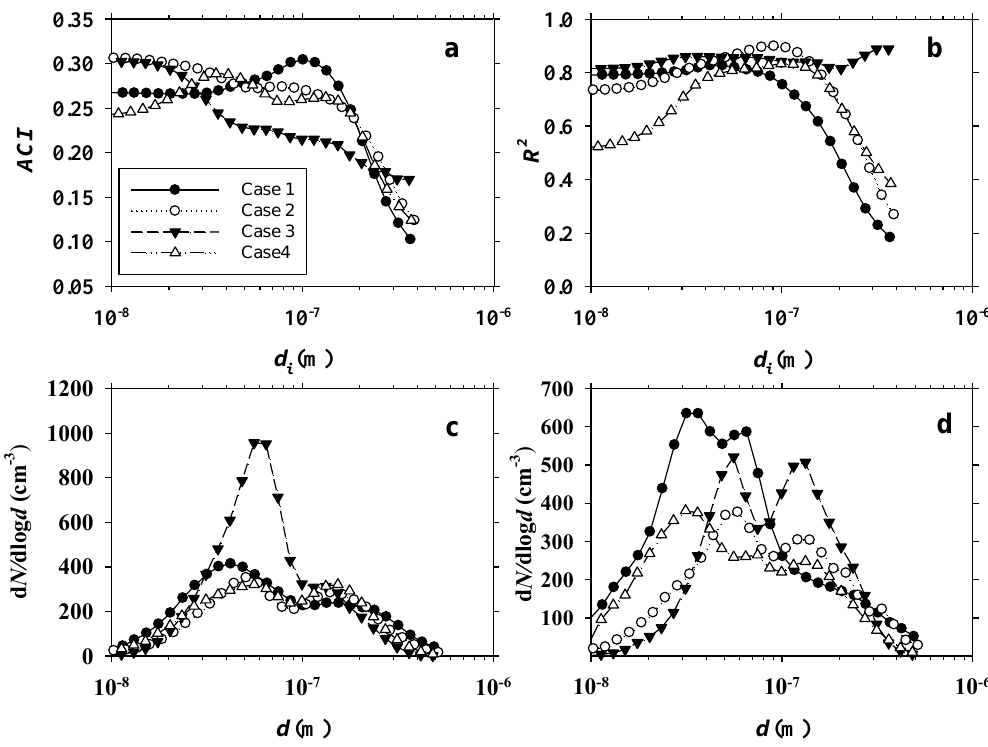
Fig. 1. (a) Aerosol-cloud interaction (ACI) from in situ data in different cases as a function of particle size. (b) Correlation coefficient ( R 2 ) between cloud and aerosol parameters as a function of particle size. (c) Average particle number size distribution in different cases, on the x-axis is the size and y-axis is the concentration. (d) Standard deviation of the particle number size distribution in each case, on the x-axis the size and y-axis is the standard deviation.